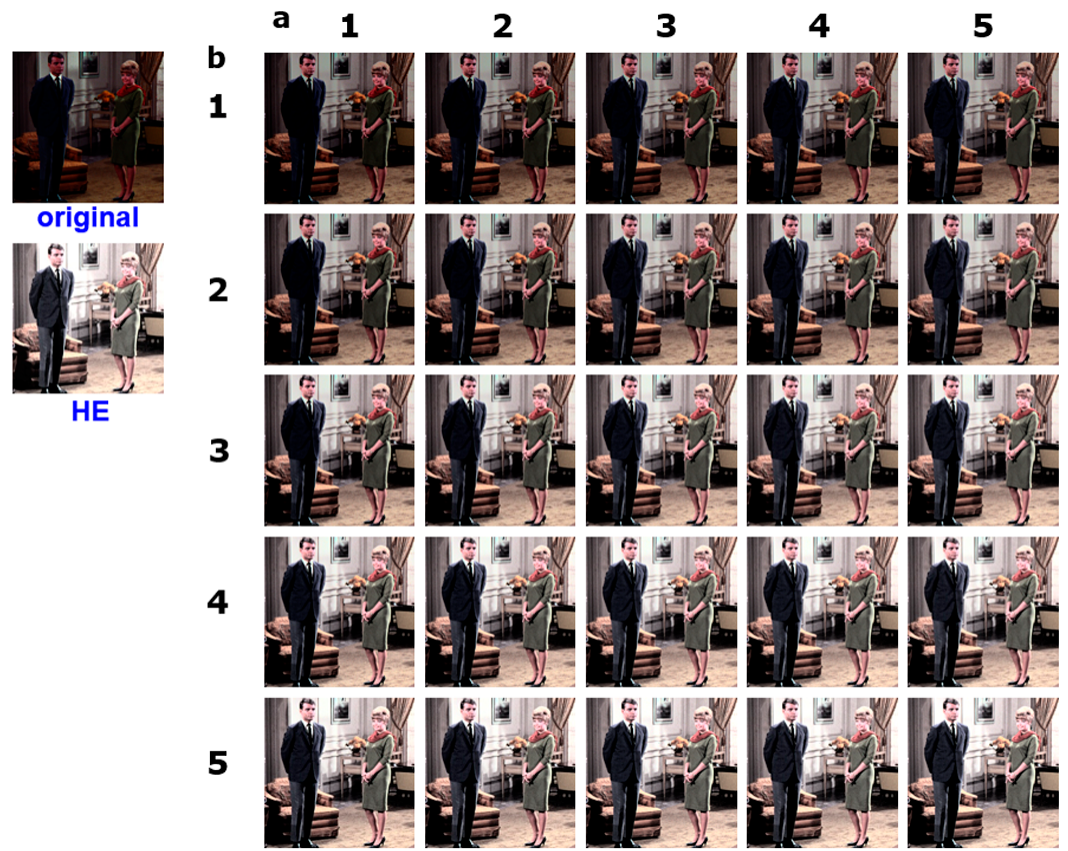
Figure A3. Image, Couple [30], processed by GA with different a and b .